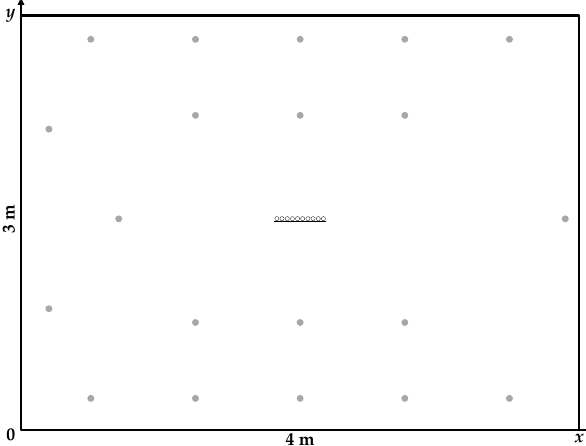
Figure 4. The abstracted meeting room acoustic environment with 20 target speech sources and a uniform linear microphone array.